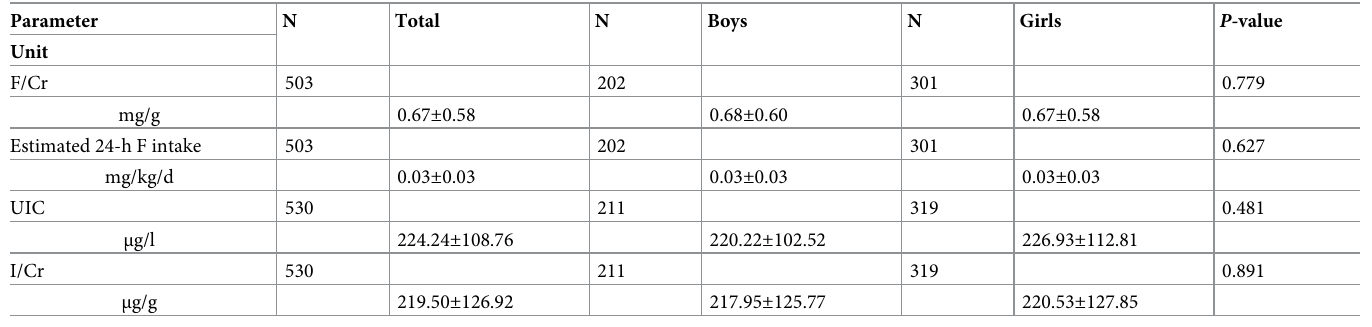
Table 3. Fluoride and Iodine statuses of elementary Emirati schoolchildren.